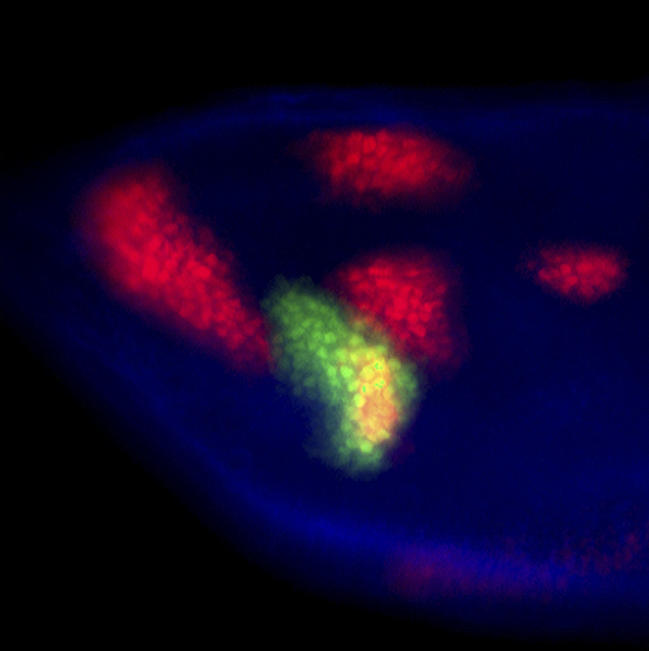
In the wing discs of Drosophila species, the divergent activities of proneural enhancers (orange versus green nuclei) contribute to the evolution of the adult bristle patterns.